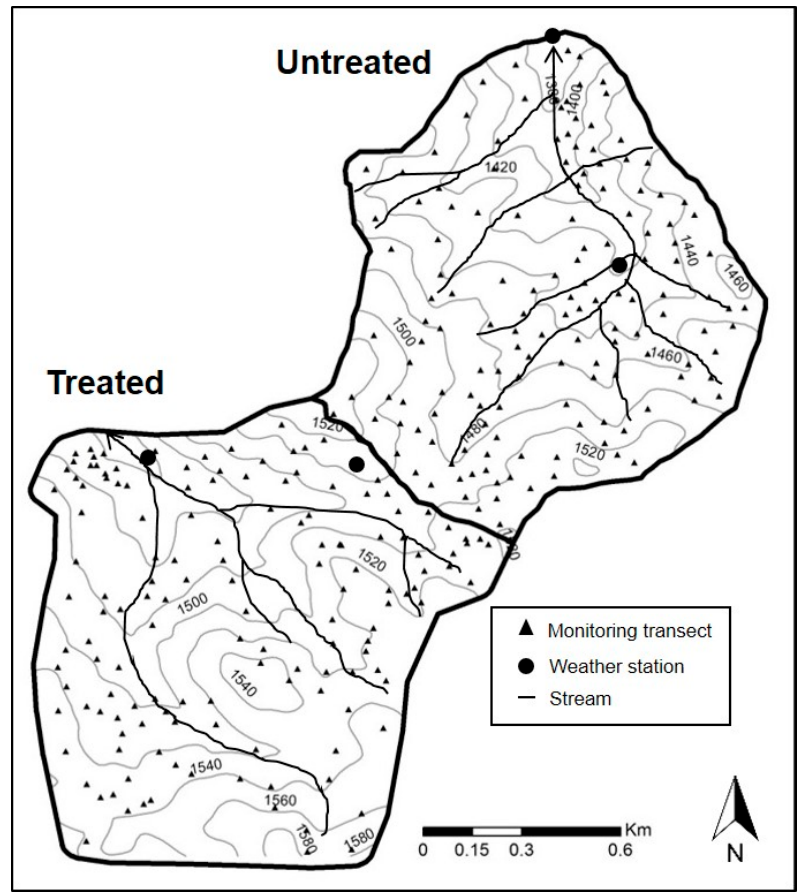
Figure 1. Map of the study site showing elevation (m) contour lines, stream network, monitoring transects, and weather station location in both watersheds.